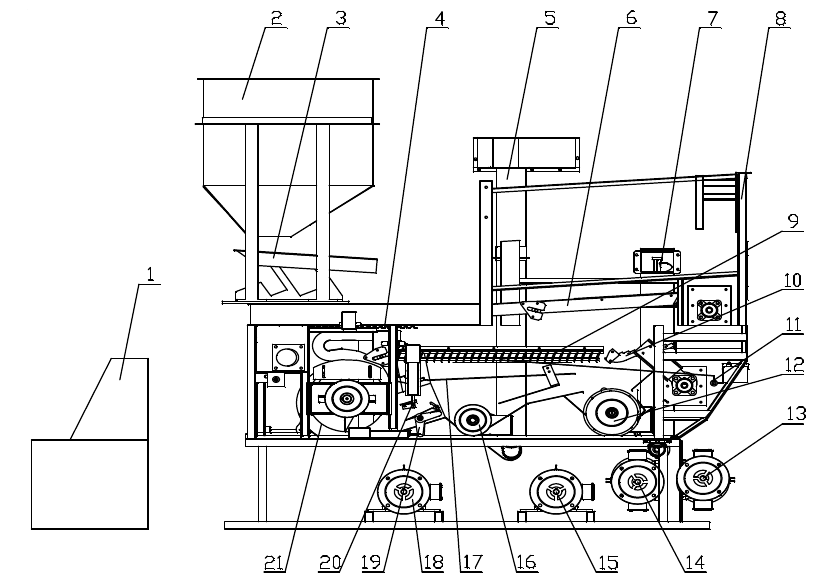
Figure 1. Schematic diagram of the multi-duct cleaning device. 1. Human–Machine Interface (HMI), 2. Threshed outputs container, 3. Electromagnetic vibration feeder, 4. Grain pan, 5. Vertical grain auger, 6. Return plate, 7. Vertical tailings auger, 8. Framework, 9. Louver sieve, 10. Tailing sieve, 11. Sieve-opening adjusting mechanism, 12. Horizontal tailing auger, 13. Sieve-driven motor, 14. Return plate-driven motor, 15. Grain/tailing auger-driven motor, 16. Horizontal grain auger, 17. Woven screen, 18. Fan-driven motor, 19. Airflow deflector i adjustment mechanism, 20. Airflow deflector ii adjustment mechanism, and 21. Centrifugal fan.